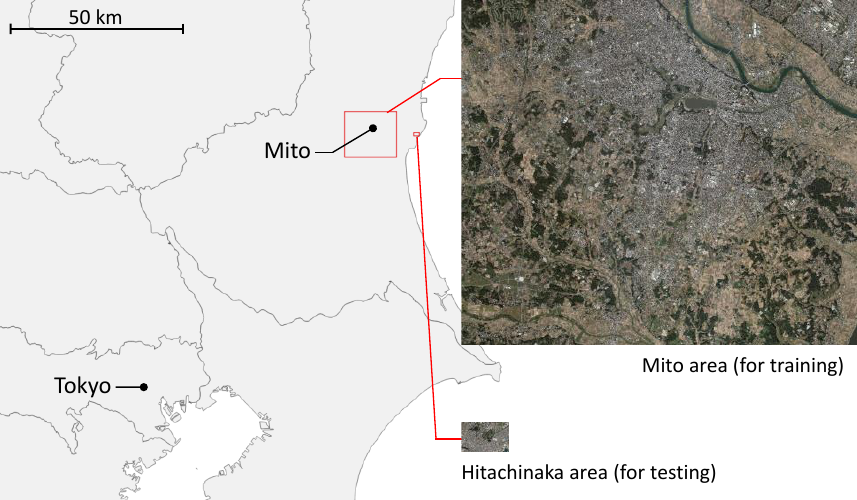
Figure 3 . Location of study area in Mito City and Hitachinaka City, Japan. Figure 3. Location of study area in Mito City and Hitachinaka City,